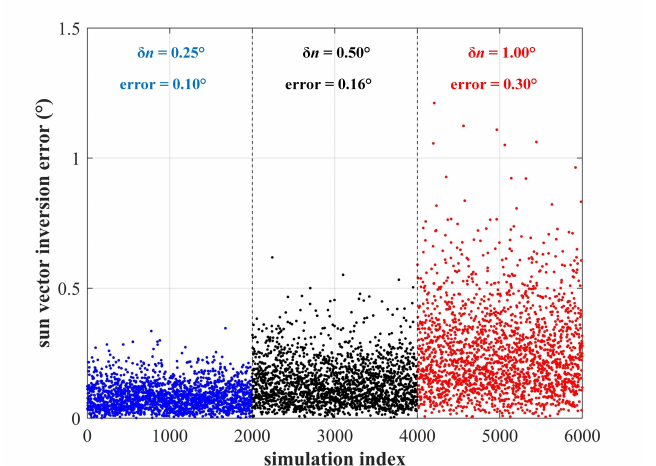
Figure 7. The sun vector inversion accuracy considering installation error of various